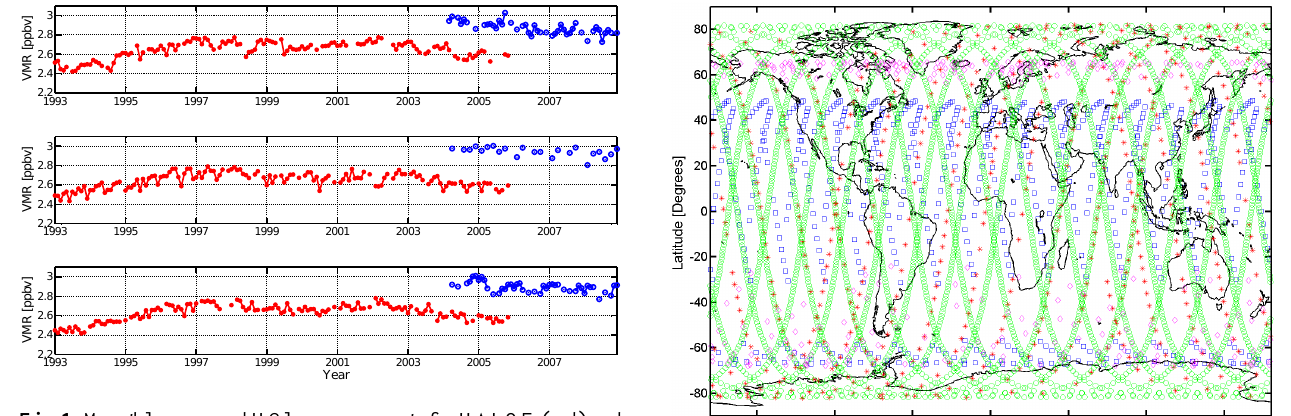
Fig. 1. Monthly averaged HCl measurements for HALOE (red) and ACE-FTS (blue) for 35–45km in three latitude bands. Top, 30 ◦ N– 50 ◦ N. Middle, 20 ◦ S–20 ◦ N. Bottom, 30 ◦ S–50 ◦ S.